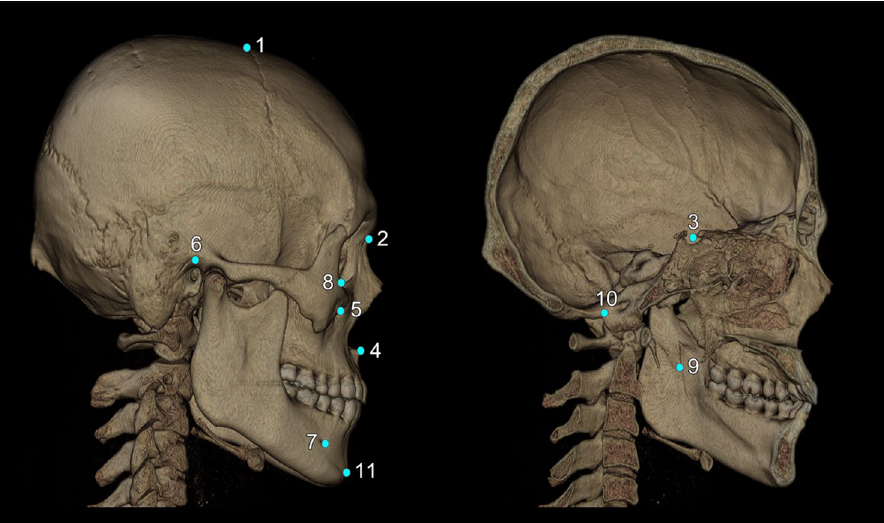
Figure 3. 3D cephalometric landmarks used in this study were marked on the skull, some of them on the surface and others inside the skull; others were in the confined space. The total number of landmarks was 16, five being bilateral. All landmarks are defined and explained in Supplementary Table 1. They are also classified into three landmark types according to Bookstein’s landmark classification, as seen below in notes 2–4. Note (1) the name of landmarks used in this study: 1. bregma; 2. nasion; 3. sella; 4. anterior nasal spine (ANS); 5. infraorbital foramen (IOF, bilateral); 6. porion (bilateral); 7. mental foramen (MF, bilateral); 8. orbitale (bilateral); 9. mandibular foramen (F, bilateral); 10. center of foramen magnum (CFM); 11. Pogonion. Note (2) Type 1 landmarks (n = 2): bregma, nasion. Note (3) Type 2 landmarks (n = 8): sella, anterior nasal spine, infraorbital foramen, orbitale, mental foramen. Note (4) Type 3 landmarks (n = 6); porion, center of foramen magnum, mandibular foramen,